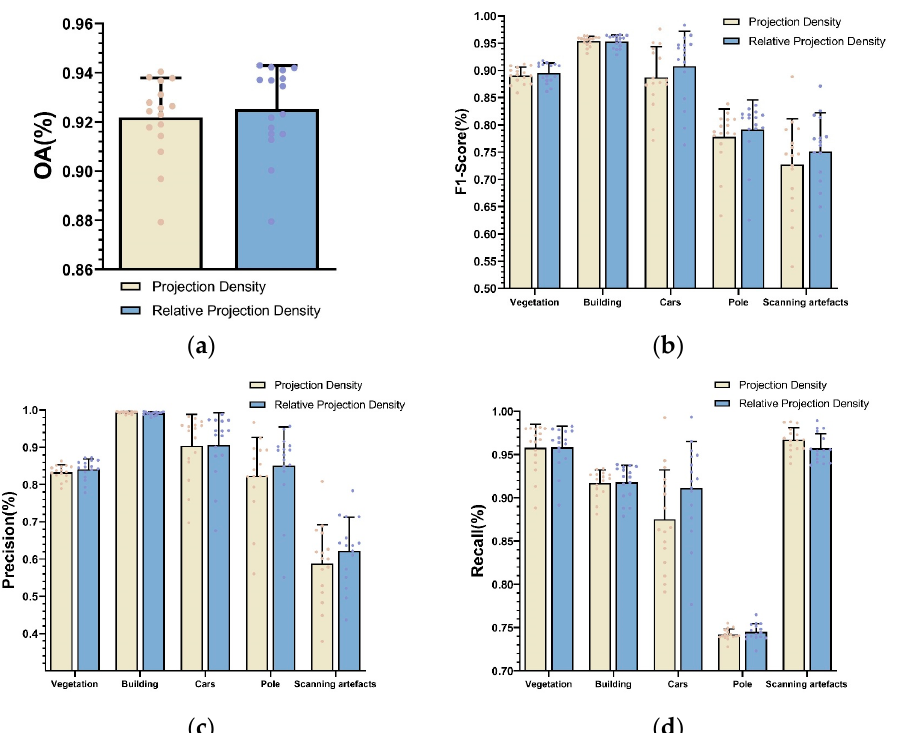
Figure 13. Comparison of the metric values obtained by traditional projection density and relative projection density. The error bars indicate the standard deviation of 160 runs (10 runs for each parameter). ( a ) Overall Accuracy, ( b ) F1-Score, ( c ) Precision, ( d ) Recall.